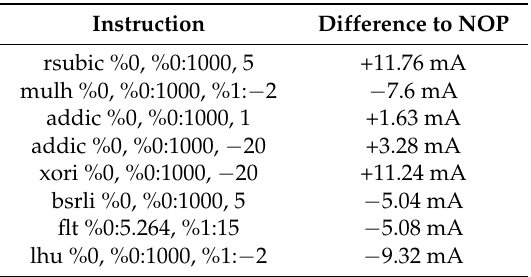
Table 1. Examples of instruction